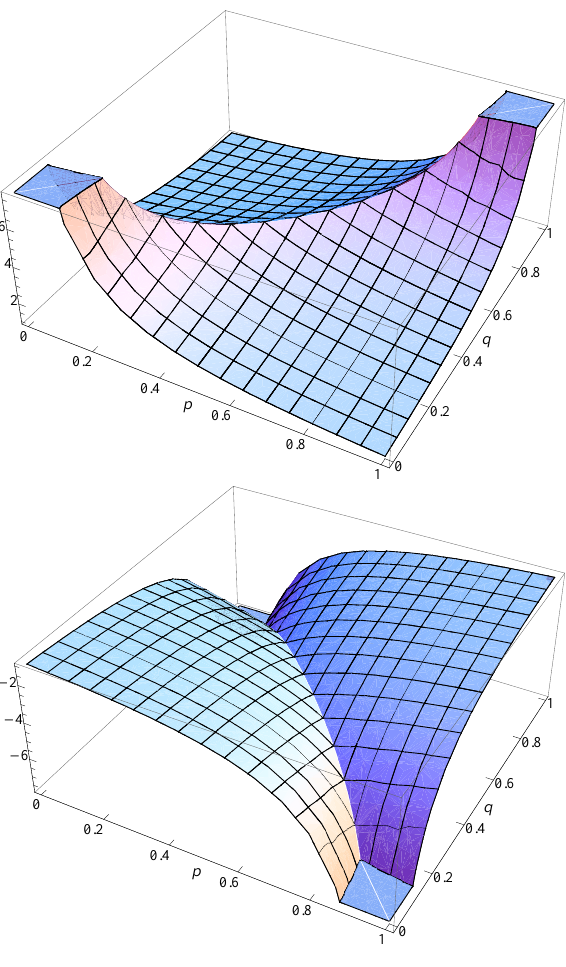
Figure 1: θ + (top figure) and θ − (bottom) as functions of ( p , q